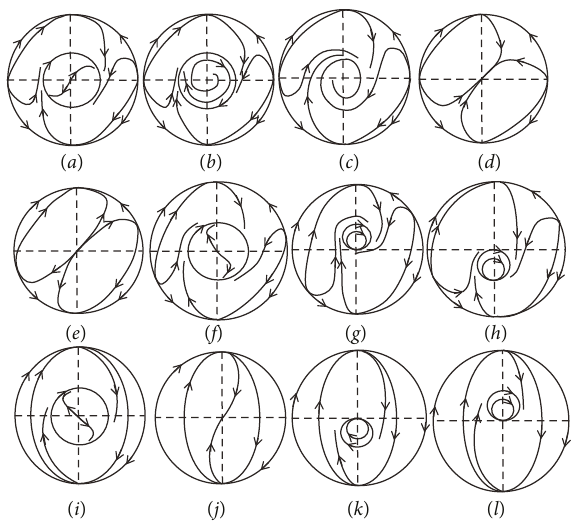
Figure 1: The global phase portraits of system (4) as the parameter 𝑎 > 0 .